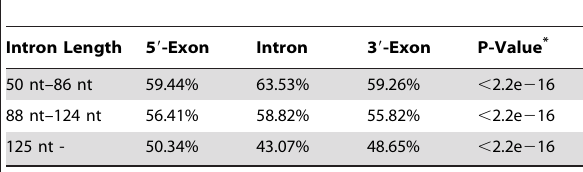
Table 3. RDI (DAF , 0.1) under variable size intervals and